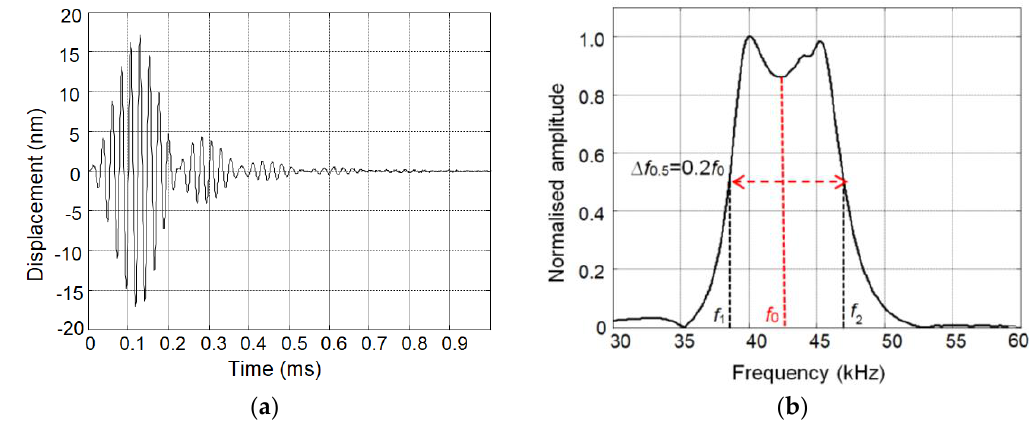
Figure 5. The measured ultrasonic signals of single element of the air-coupled array: ( a ) waveform; and ( b ) normalized spectrum.